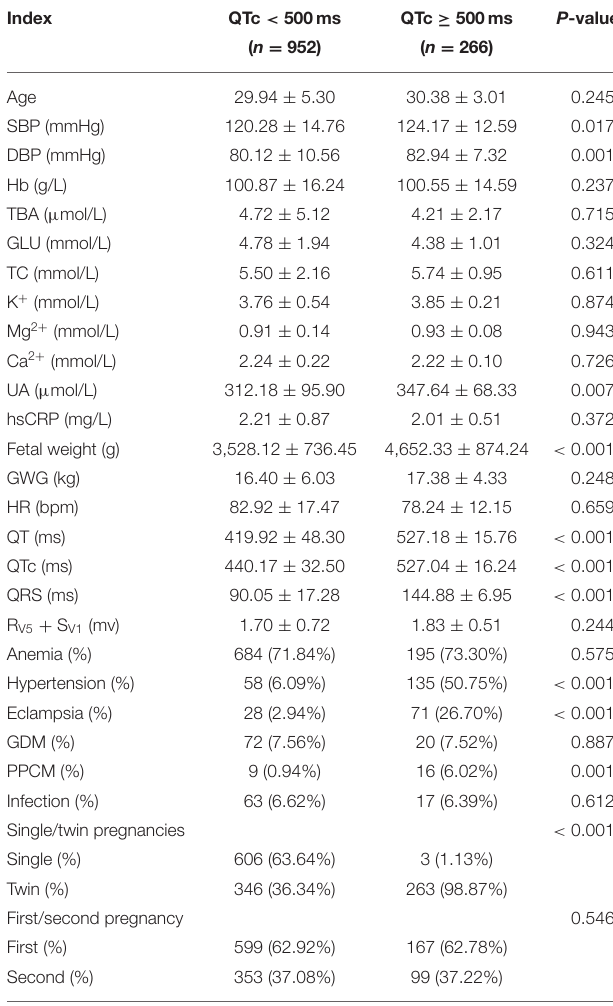
TABLE 4 | Multivariable logistic regression analysis indicated risk factors significantly correlated with QTc prolongation in parturient. Variables